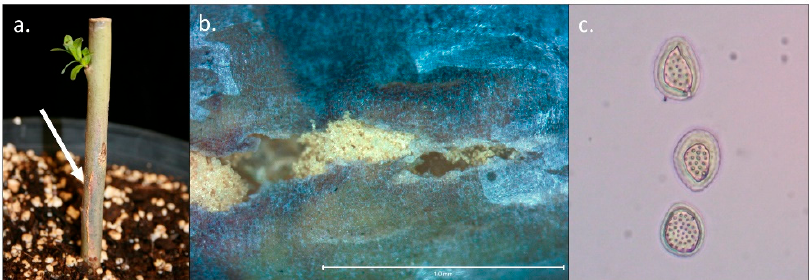
Figure 4. Melampsora paradoxa recovery from dormant stem canker after overwintering. ( a ) Image of cutting after approximately three weeks in the greenhouse following dormancy in the field. Arrow points to stem uredospore pustules that developed after stems broke dormancy ( b ) Micrograph of stem rust identified by arrow taken at 30× with dissecting microscope. ( c ) Micrograph of uredospores collected from stem pustules taken at 40× with a compound microscope.